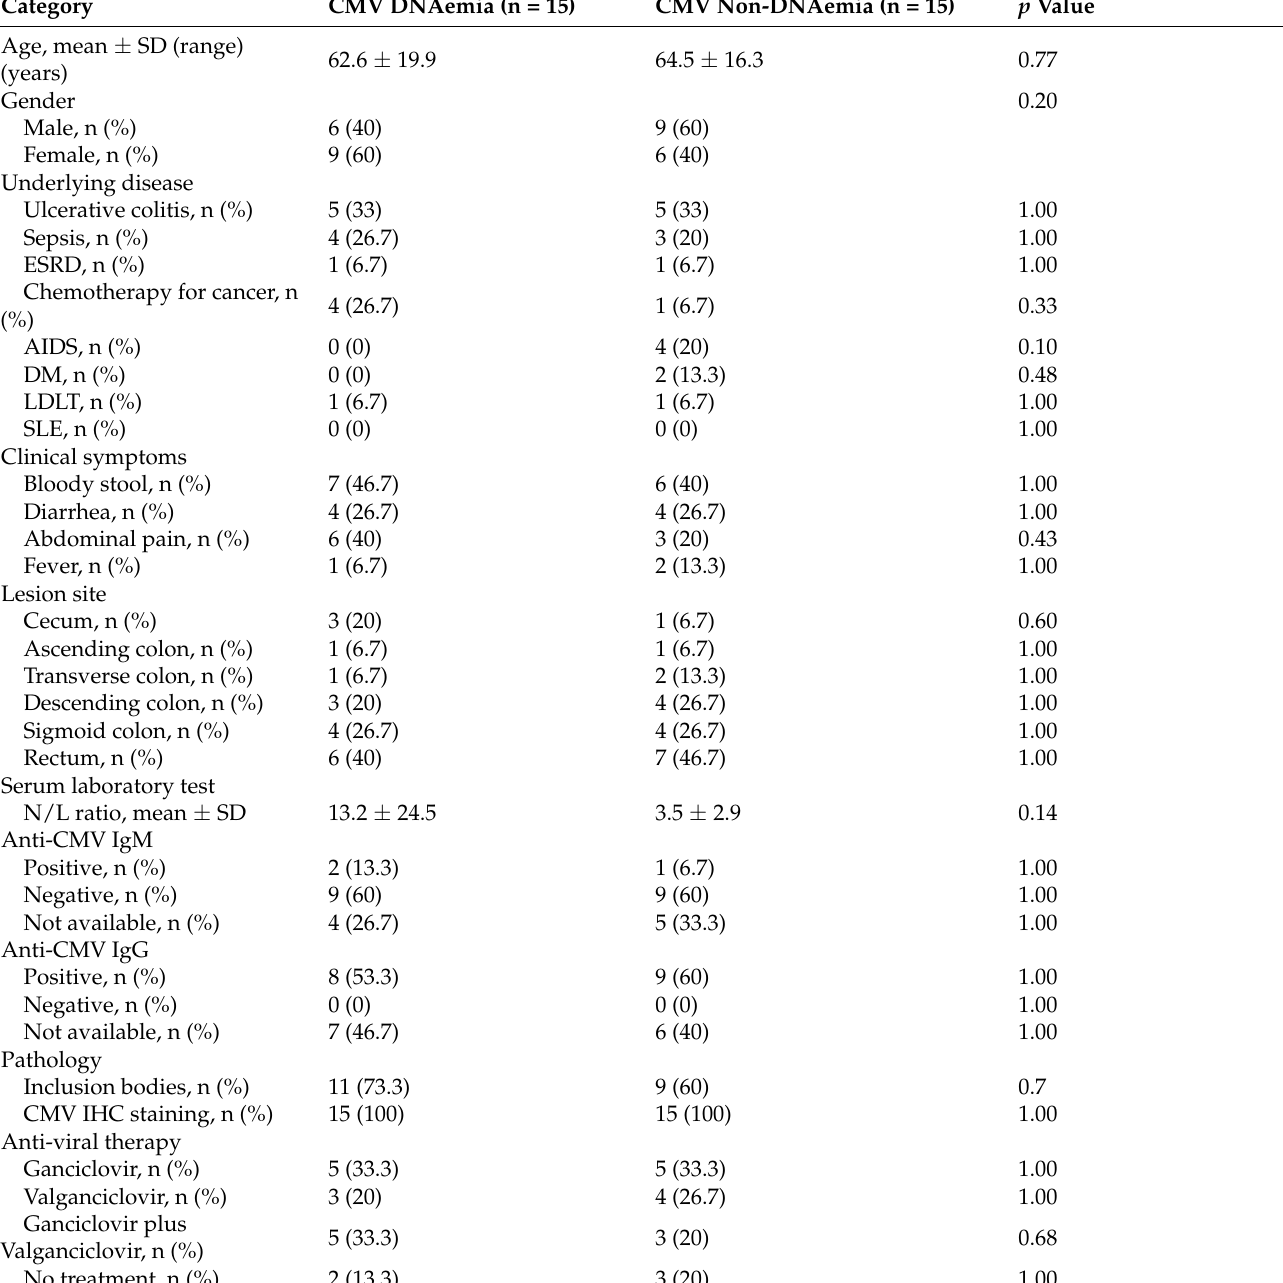
Table 2. Comparison of biopsy-proven CMV colitis patients with and without CMV